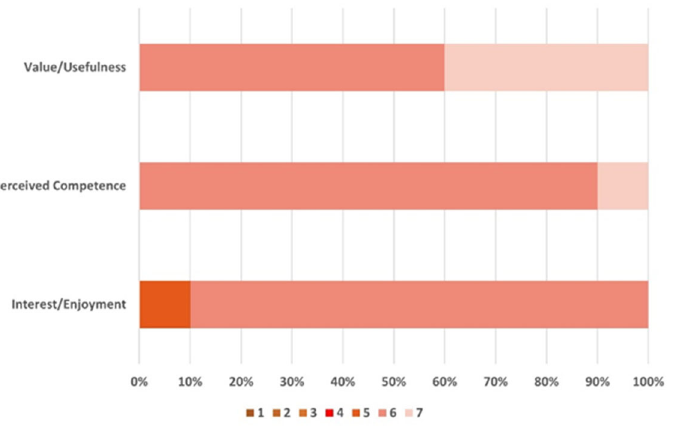
Figure 12. Response to the IMI questionnaire regarding interest/enjoyment, perceived competence, and value/usefulness of our system.